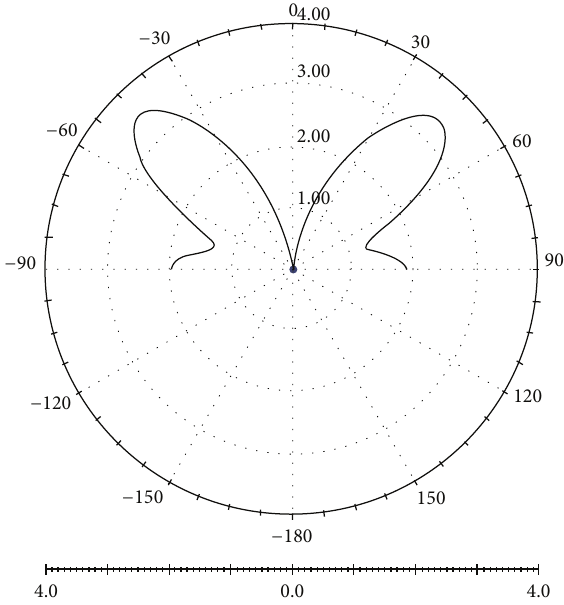
Figure 5: Radiation pattern of the plasma antenna from HFSS model.